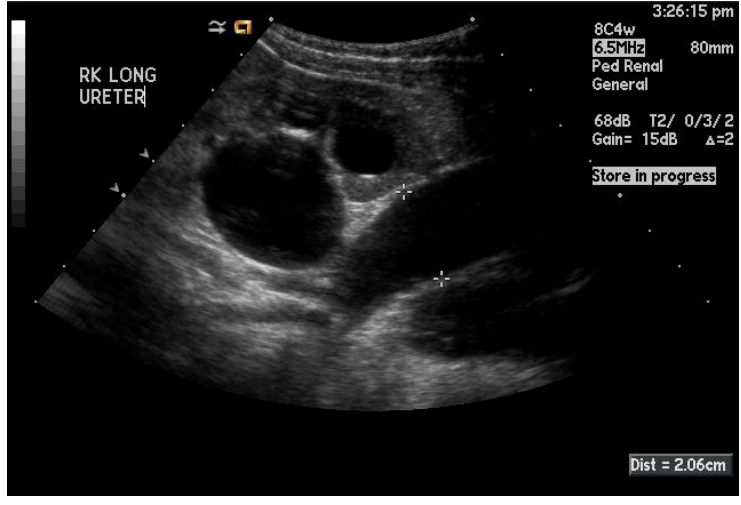
FIGURE 1. Ultrasound from obstructed megaureter demonstrating dilated collecting system and proximal ureter.